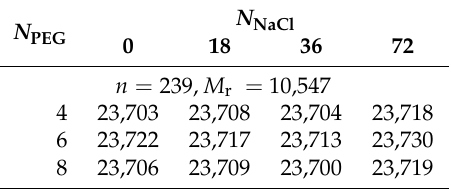
Table 3. Weight fractions (%) of PEG in production runs of all the simulated systems. N PEG